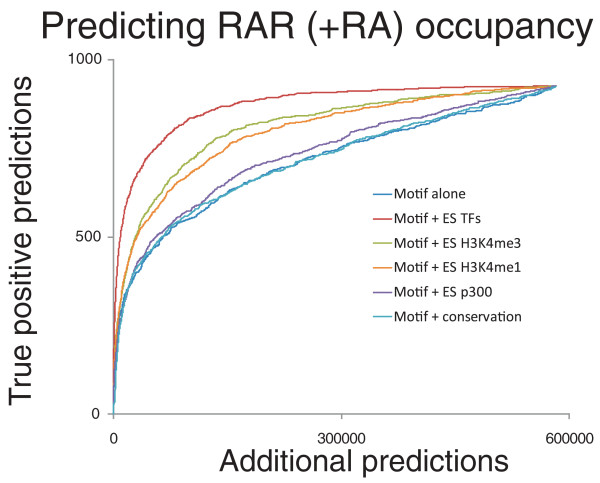
ChIP-seq data improves motif specificity. The true positive and additional prediction rates are shown when predicting post-RA RAR binding sites by ranking sites according to motif similarity or when combining motif information with various other data sources (see Materials and methods).